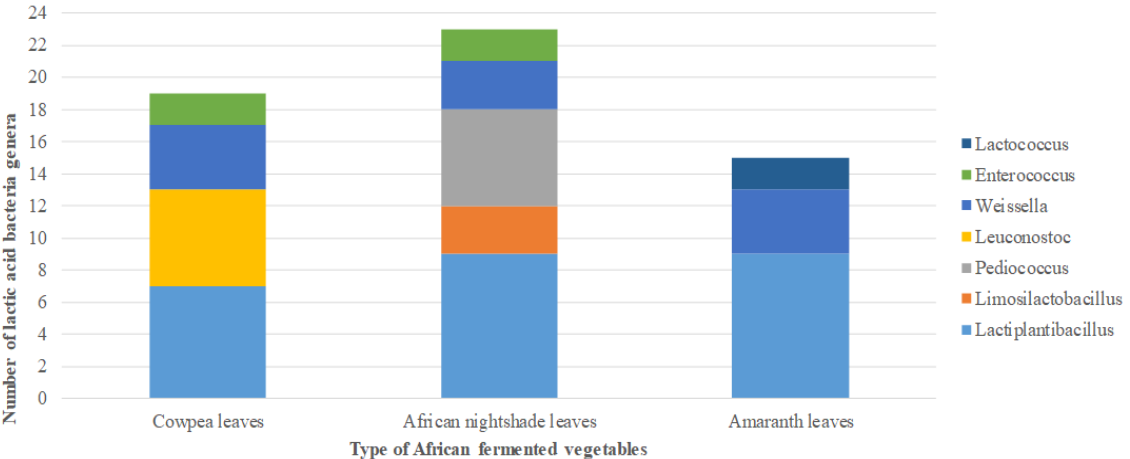
Figure 2. Lactic acid bacteria isolated from three African indigenous leafy vegetables grouped at the genus level.